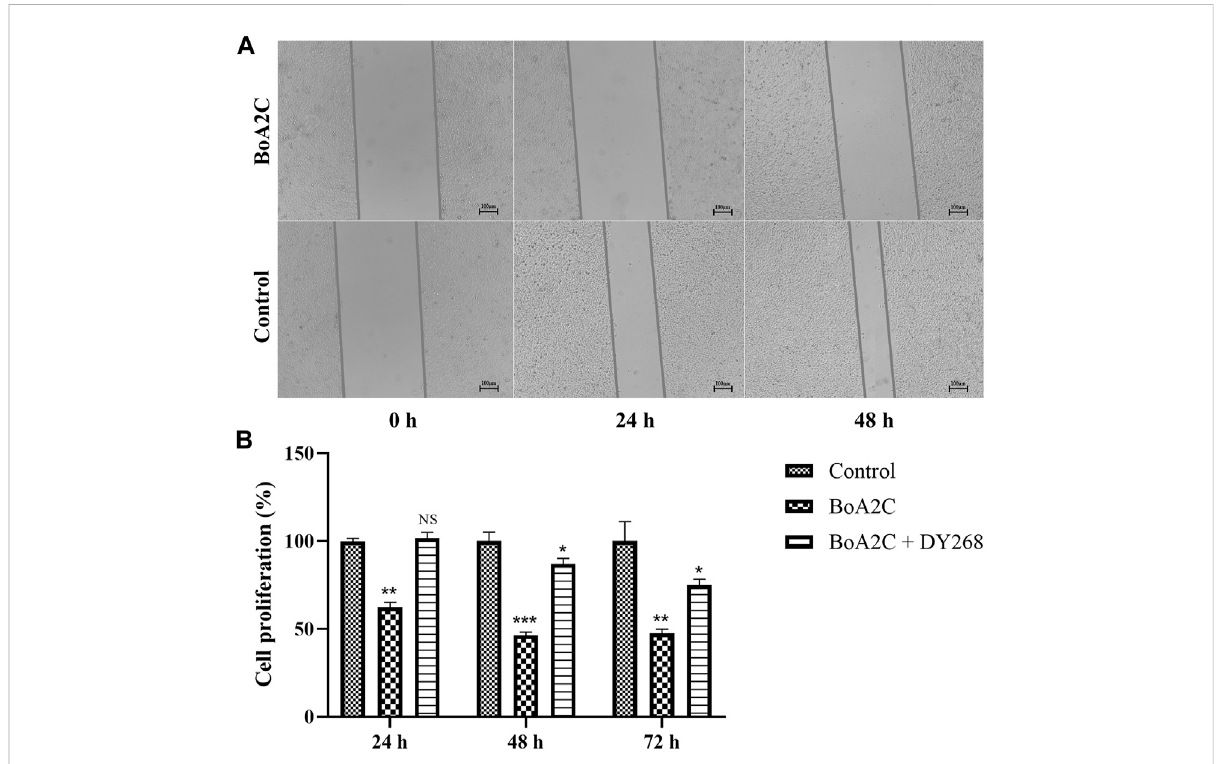
FIGURE.8 The effect of BoA2C on the invasive ability of MCF-7 cells and the role of FXR in the anticancer process. (A) Wound healing assays were performed in 0, 24, 48 h; (B) Changes of antiproliferative activity under DY268. * p < 0.05, ** p < 0.01, and *** p < 0.001 vs. control